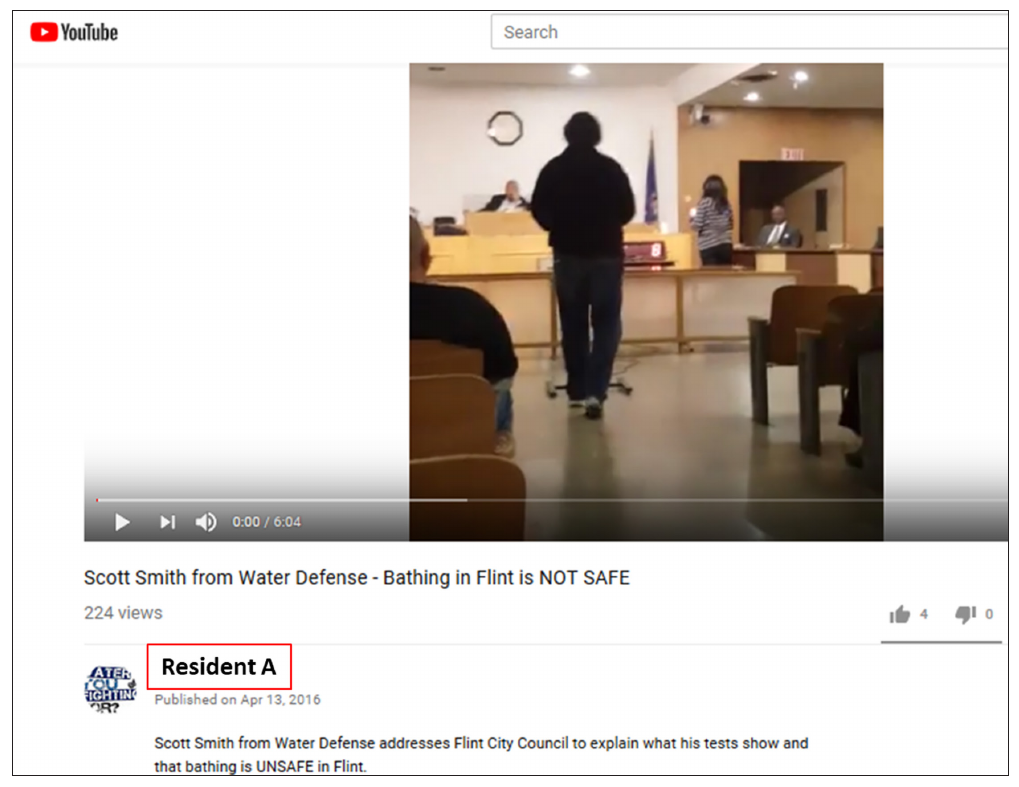
Figure 2: A partial screengrab of a public YouTube video posted by a Flint resident (Resident A) using Water Defense data/assertions to declare “Bathing in Flint is NOT SAFE”. (image edited to remove Resident A’s real name from